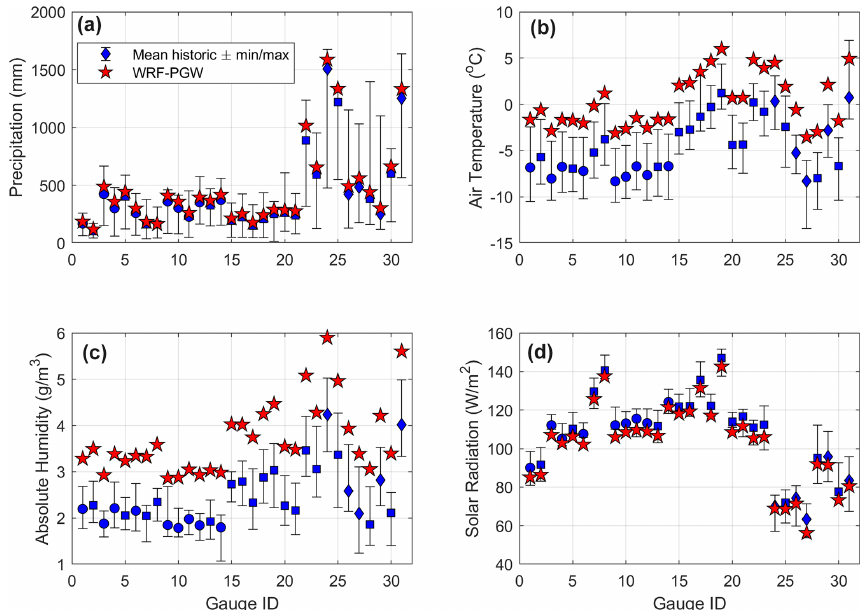
Figure A4. Historic winter climate variability for each predictor used in the stepwise MLR model (Eq. 1) for the period between November and DOS 20 in blue. (a) Precipitation, (b) air temperature, (c) absolute humidity, and (d) solar radiation. In red are the perturbed mean climate variables under the RCP8.5 pseudo global warming scenario by the end of the century. This analysis suggests that most of the climate change signal from NoahMP-WRF pseudo global warming is within the observed climate variability, except for air temperature and atmospheric humidity in some watersheds. Blue symbols (circle, square, and diamond) associated with historical values represent the mean annual percentage of clear-sky snowmelt days, where sunny sites have > 90% clear-sky snowmelt days, partly cloudy have between 70% and 90%, and cloudy have < 70%; clear-sky snowmelt days are defined as those with more than 80% of the potential clear-sky solar radiation. We make no inference about the cloudiness condition of snowmelt days under the RCP8.5 pseudo global warming scenario, and thus, we use a five-point star (in red) for the future scenario.